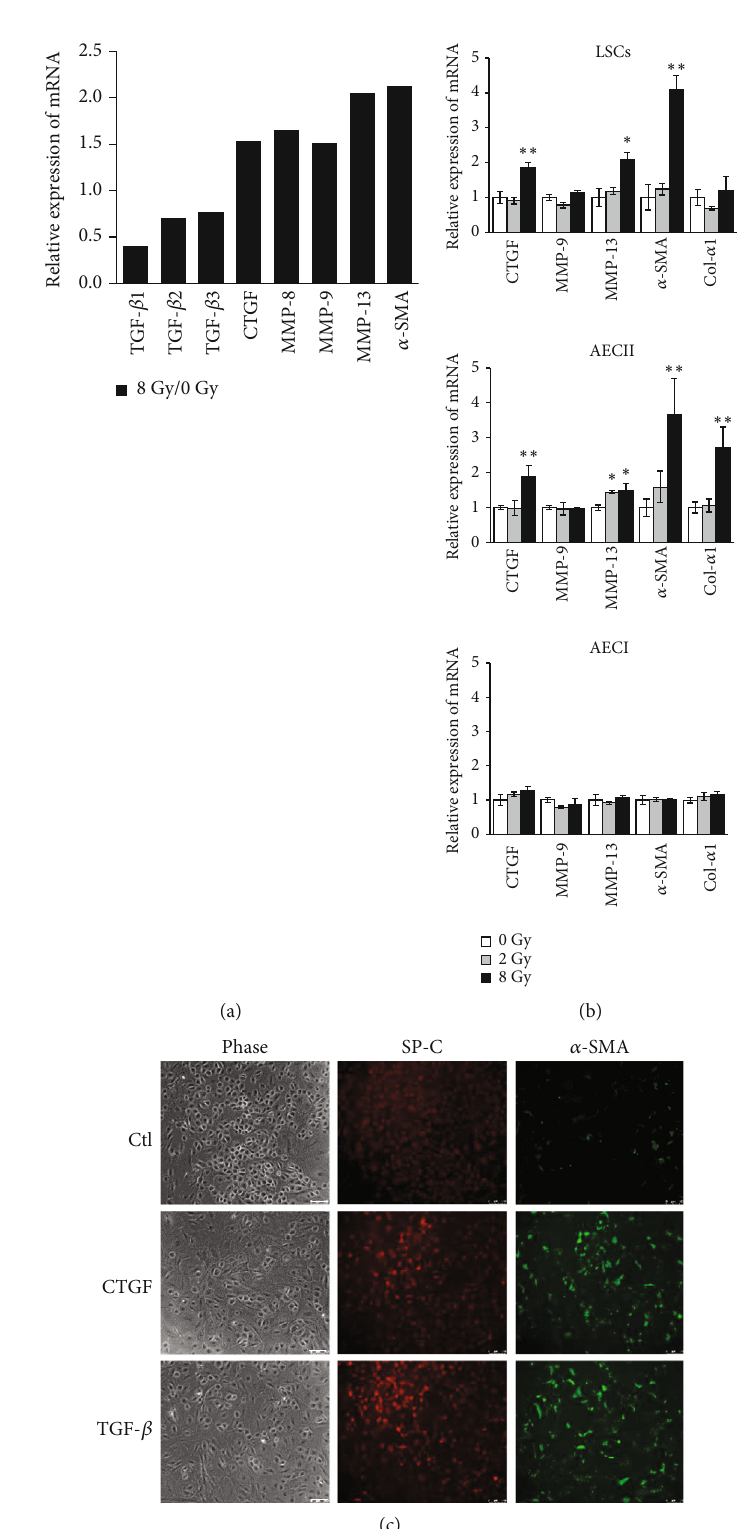
Figure 4: Radiation exposure promotes fi brogenic signaling in LSCs and AECII cells. (a) The mRNA was extracted from LSCs after treatment with or without 8 Gy X-ray followed by incubation under normal conditions for 7 days. Relative gene expression was examined by the Fibrosis PCR Array. (b) The mRNA was extracted from LSCs, AECII, and AECI cells exposed to 2 or 8Gy. The relative levels of the indicated mRNAs were measured by real-time PCR. The data were normalized to GAPDH and expressed relative to nonradiated control cells. (c) LSCs were treated with CTGF (50 ng/ml) or TGF- β (5 ng/ml) for 3 days, and the populations of α -SMA + and SP-C + cells were analyzed. Scale bars, 100 μ